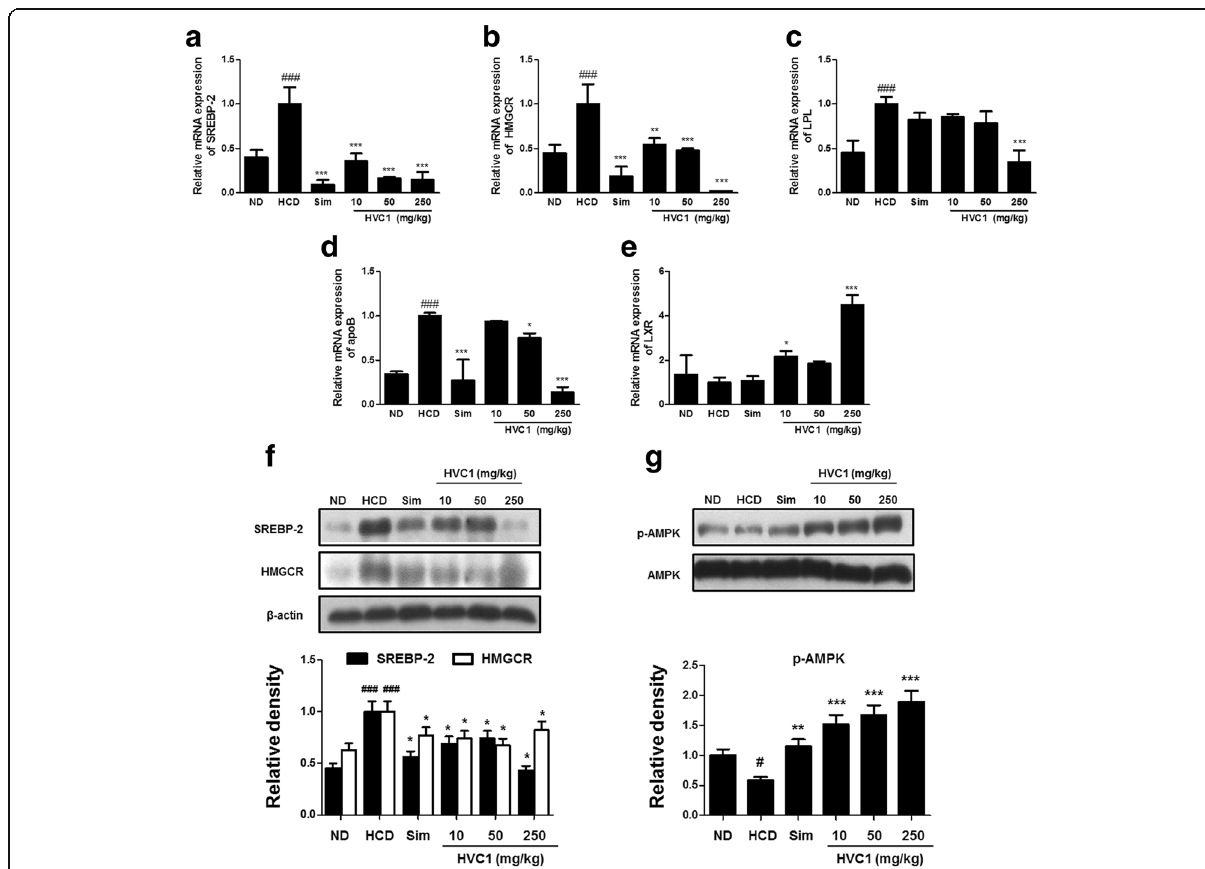
Fig. 4 HVC1 regulation of cholesterol metabolism and lipid synthesis in LDLR − / − mice. Total RNA was subjected to real-time PCR as described in the Methods section. Cholesterol and lipid metabolism-related genes mRNA levels were analyzed by real-time PCR analysis. ( a ) SREBP-2, ( b ) HMGCR, ( c ) LPL, ( d ) apoB, and ( e ) LXR. Protein levels of ( f ) SREBP-2, ( g ) HMGCR, (H) p-AMPK, and AMPK in liver tissues were analyzed by western blot. Proteins were determined by western blot assay using specific antibody. β -actin was used as a loading control. Values represent mean ± S.D. of three independent